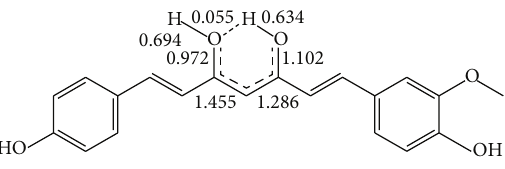
Figure 3: Bond orders of [dCurc + H] +